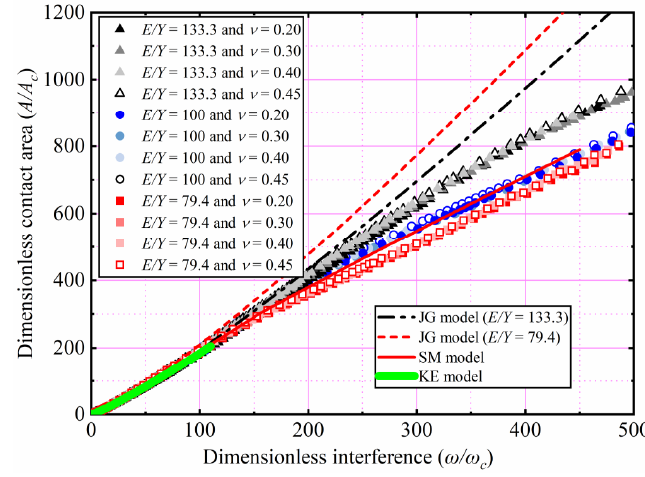
Figure 9. A / A c as a function of ω / ω c for different Y , ν and E / Y ≤ 133.3. Table 7. Parameters in Equation (13).